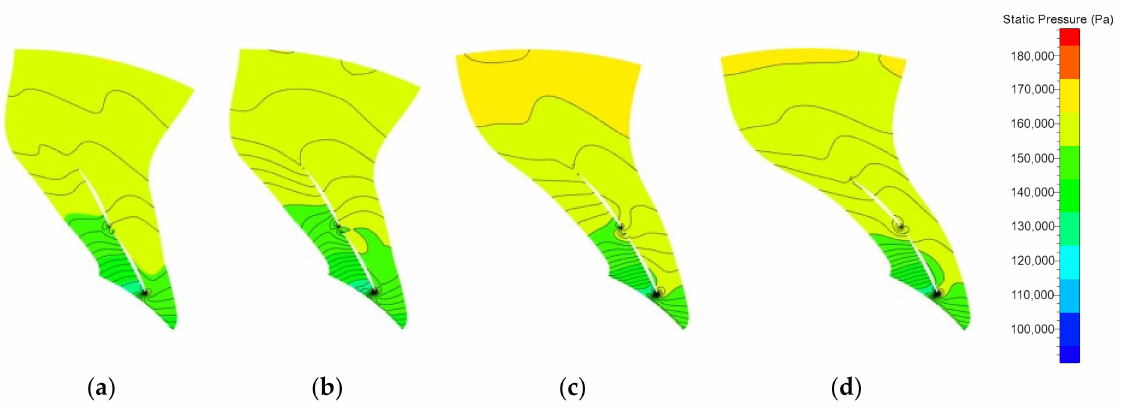
Figure 13. Static pressure distribution at 50% span in different cases. ( a ) 0 ◦ model; ( b ) 3 ◦ model; ( c ) 10 ◦ model; and ( d ) 18 ◦